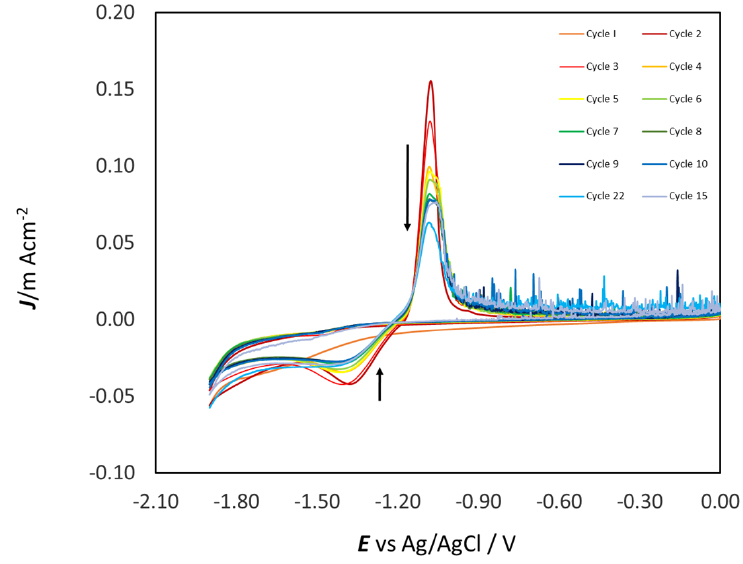
Figure 5. Multiple-cycle voltammograms in 0.3 M ZnSO 4 in ChU with GC electrode (first: red line, last: blue line) at 25 °C and 10 mV s −1 .